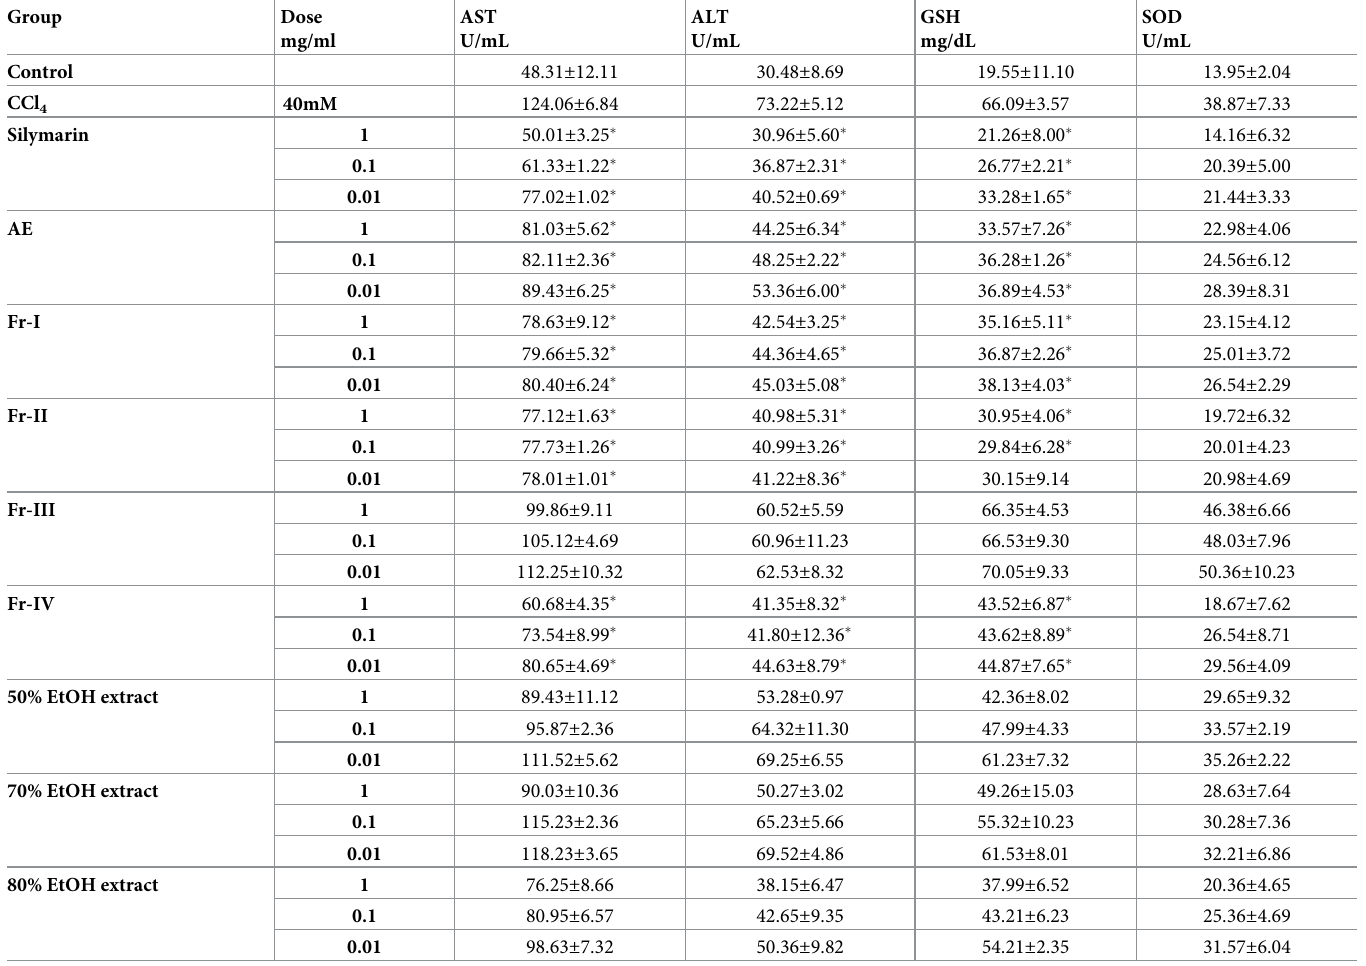
Table 1. Protective effect of different extracts and fractions of P . niruri on CCl 4 induced toxicity in clone-9 cell line.